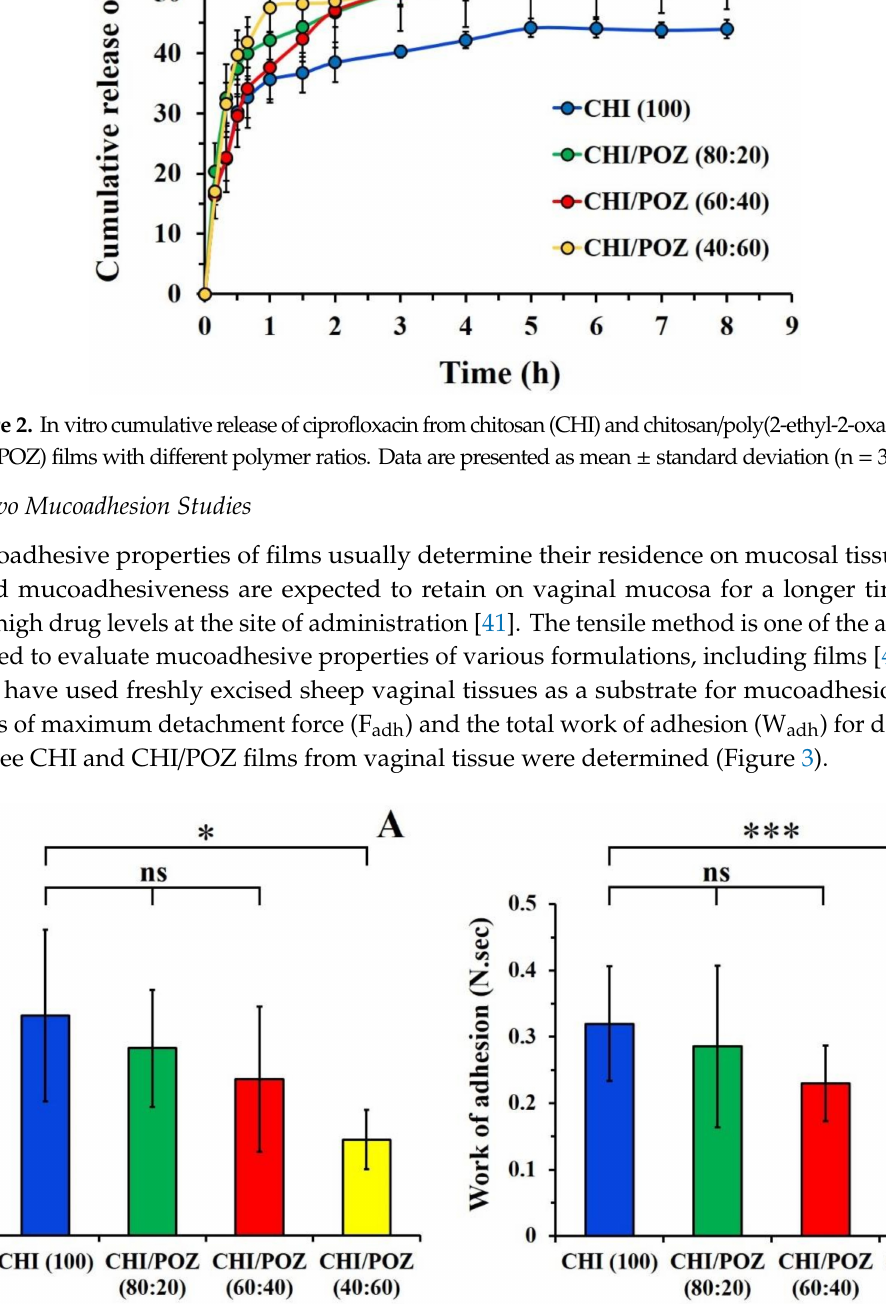
Figure 3. Detachment force F adh ( A ) and total work of adhesion W adh ( B ) values for detachment of chitosan (CHI) and chitosan / poly(2-ethyl-2-oxazoline) (CHI / POZ) blend films from sheep vaginal mucosa. Data are expressed as mean ± standard deviation (n = 5). Statistically significant di ff erences are given as: *— p < 0.05 ; ***— p < 0.001 ; ns—no